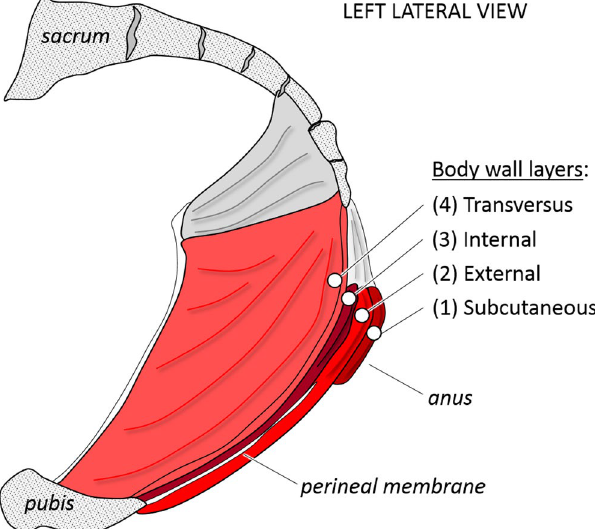
Figure 3. Anatomical organization of the perineal portion of the mammalian trunk body wall into four layers, drawn here after our human dissections. The subcutaneous layer is formed by M. sphincter ani externus pars subcutanea . The external layer includes M. bulbospongiosus , M. ischiocavernosus and M. transversus perinei superficialis . The internal muscle layer is formed by M. sphincter ani externus pars profundus , M. transversus perinei profundus , and the urethral sphincter muscles. The transversus layer includes M. levator ani and M. coccygeus